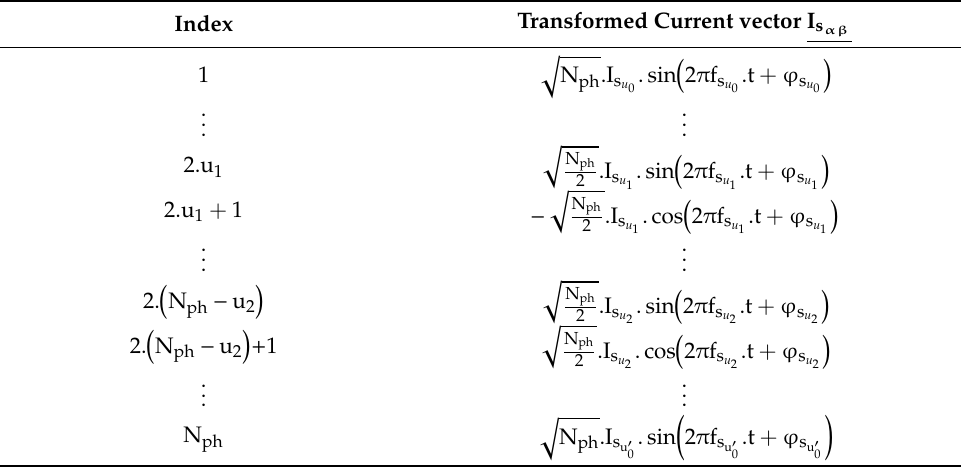
Table 1. Transformed stator current vector I s